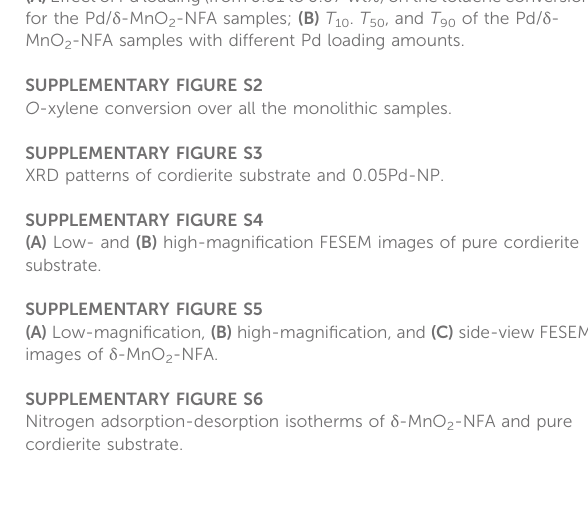
SUPPLEMENTARY FIGURE S2 O -xylene conversion over all the monolithic samples. SUPPLEMENTARY FIGURE S3 XRD patterns of cordierite substrate and 0.05Pd-NP. SUPPLEMENTARY FIGURE S4 (A) Low- and (B) high-magni fi cation FESEM images of pure cordierite substrate. SUPPLEMENTARY FIGURE S5 (A) Low-magni fi cation, (B) high-magni fi cation, and (C) side-view FESEM images of δ -MnO 2 -NFA. SUPPLEMENTARY FIGURE S6 Nitrogen adsorption-desorption isotherms of δ -MnO 2 -NFA and pure cordierite substrate.